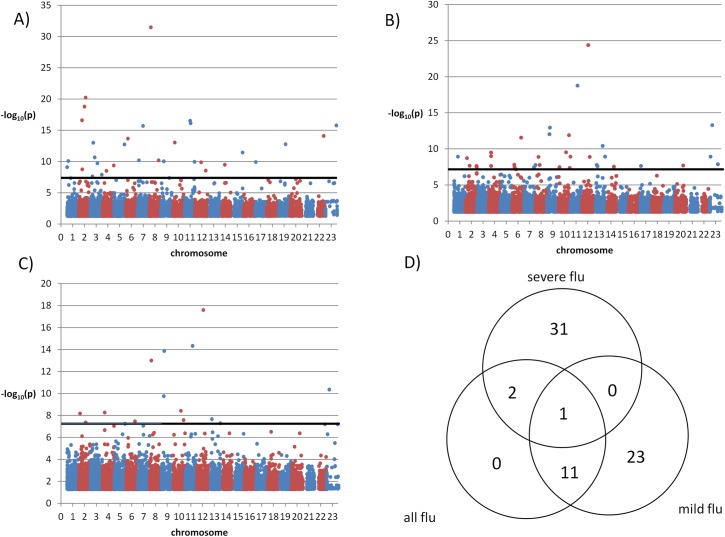
Manhattan plots of a general population sample vs.(A) severe influenza cases; (B) mild influenza cases and (C) all influenza cases. Only p-values < 0.05 are shown. (D): Venn diagram of SNPs with significant associations with p<5×10−8 when comparing severe influenza cases, mild influenza cases or all influenza cases to a general population sample.